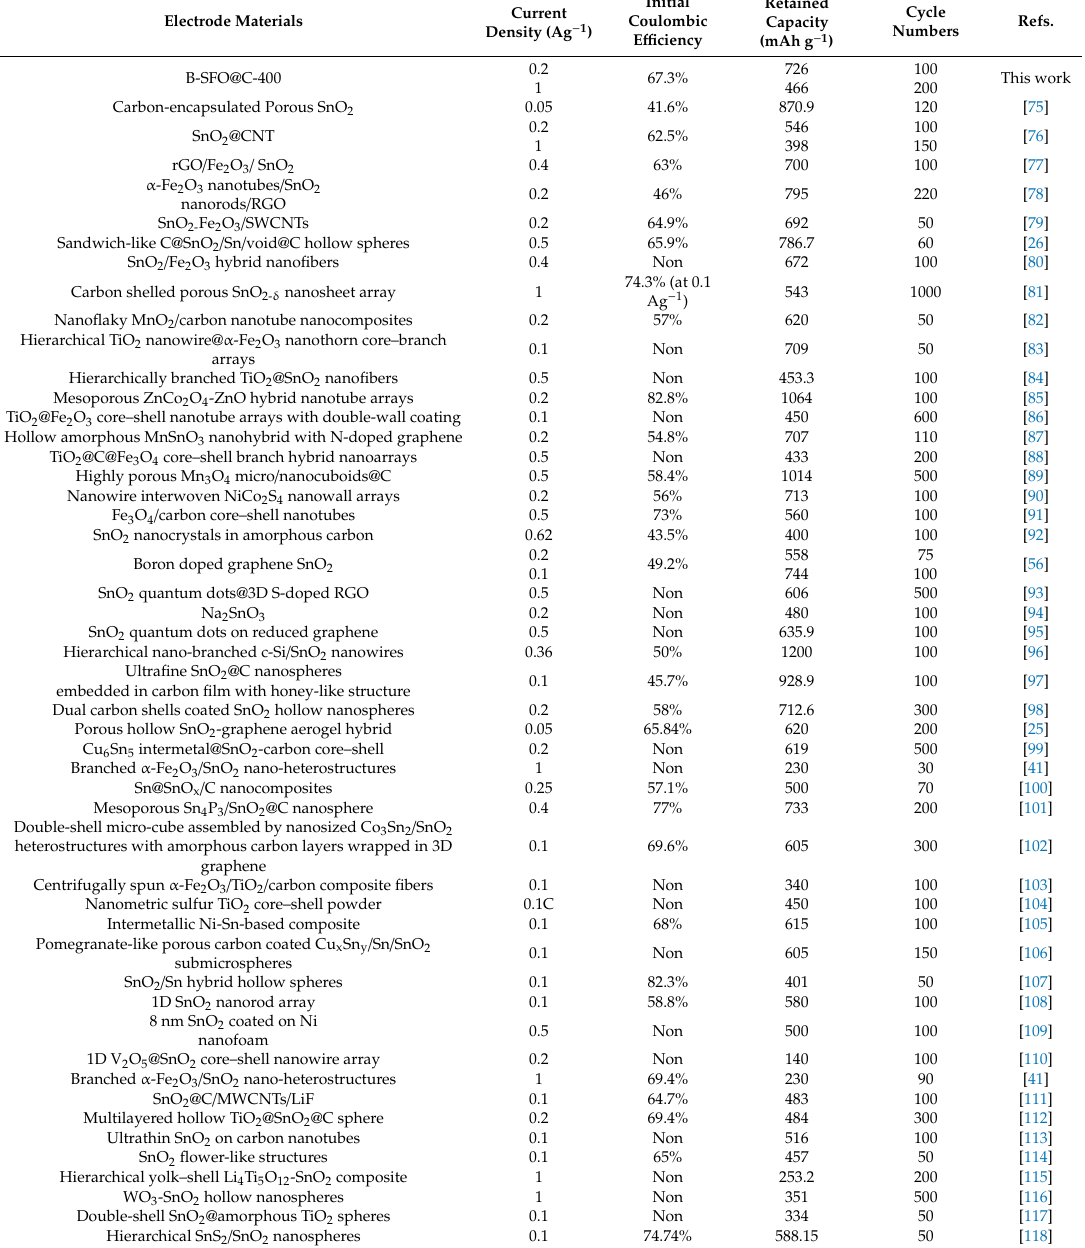
Table 1. The thorough recapitulative comparison of electrochemical performance of the optimal SFO@C with some cutting-edge SnO 2 -based materials and other metal-based anodes recorded till date. The loading of coating mostly varied from 1 to 2 mg / cm 2